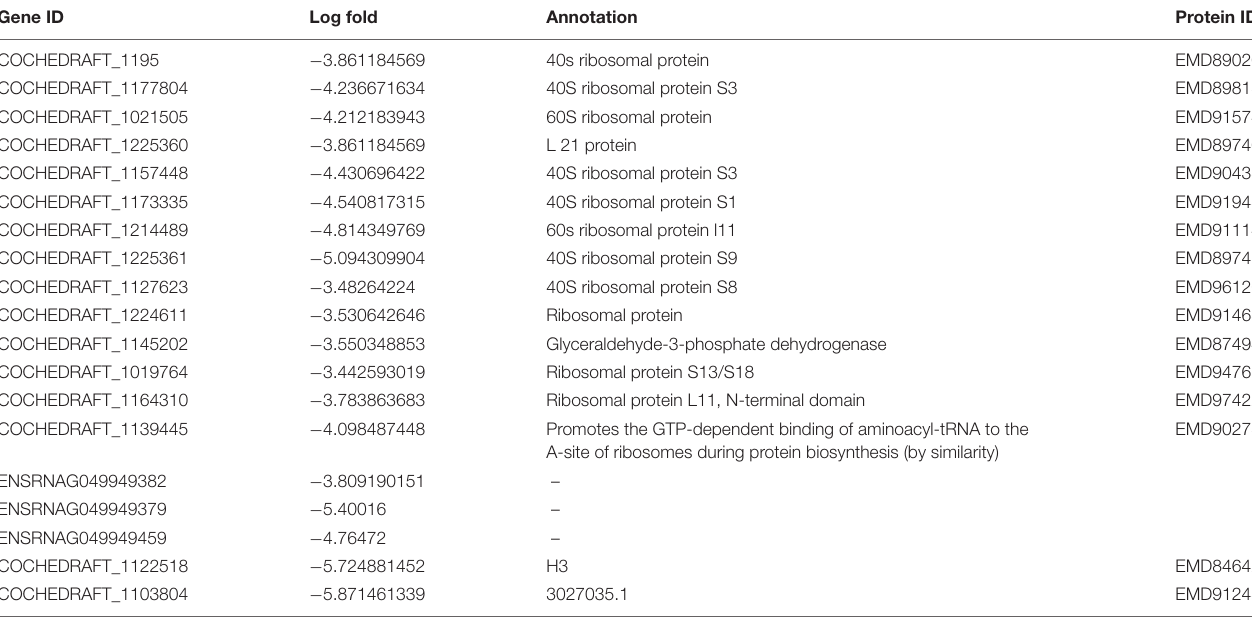
TABLE 3 | Top 20 highly downregulated genes of B. maydis differentially expressed in inoculated resistant and susceptible plants. Gene ID Log fold